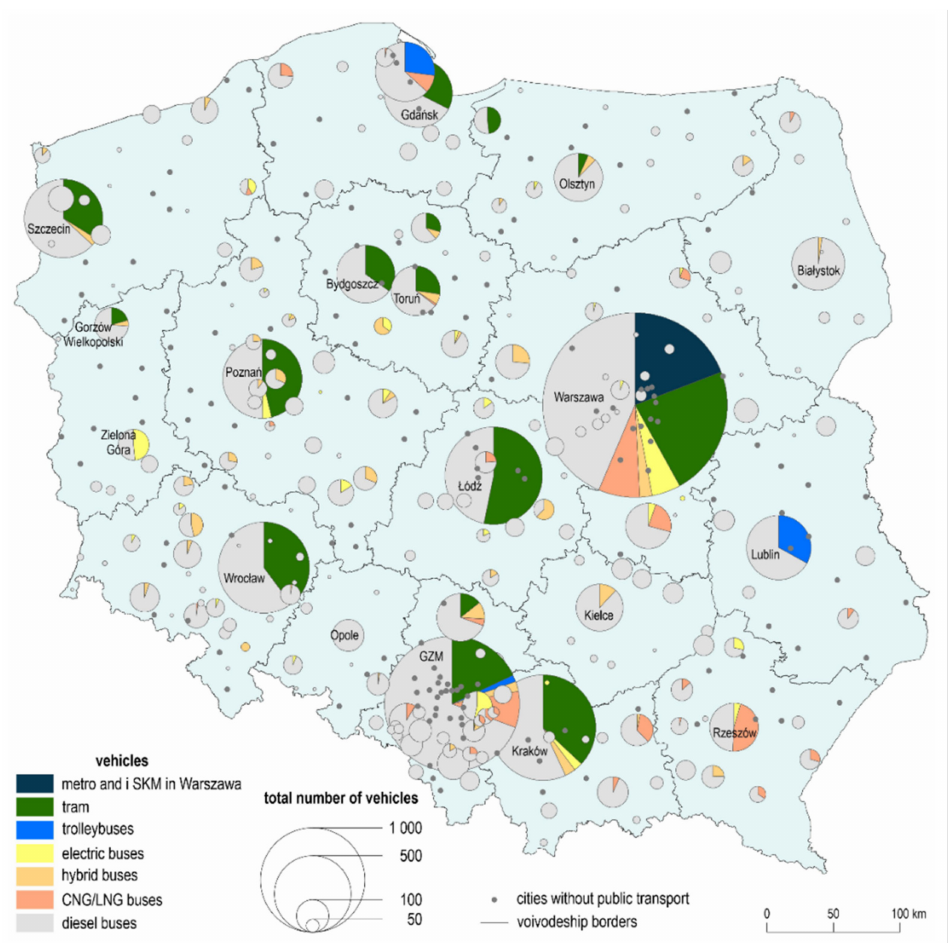
Figure 4. Distribution and structure of public transport vehicles in